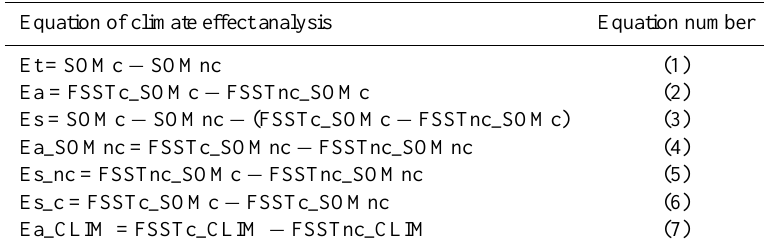
Table 2. Equation of climate effect analysis. Experiment notation is listed in Table 1, and details of experiment design for different simulations are described in Sect.